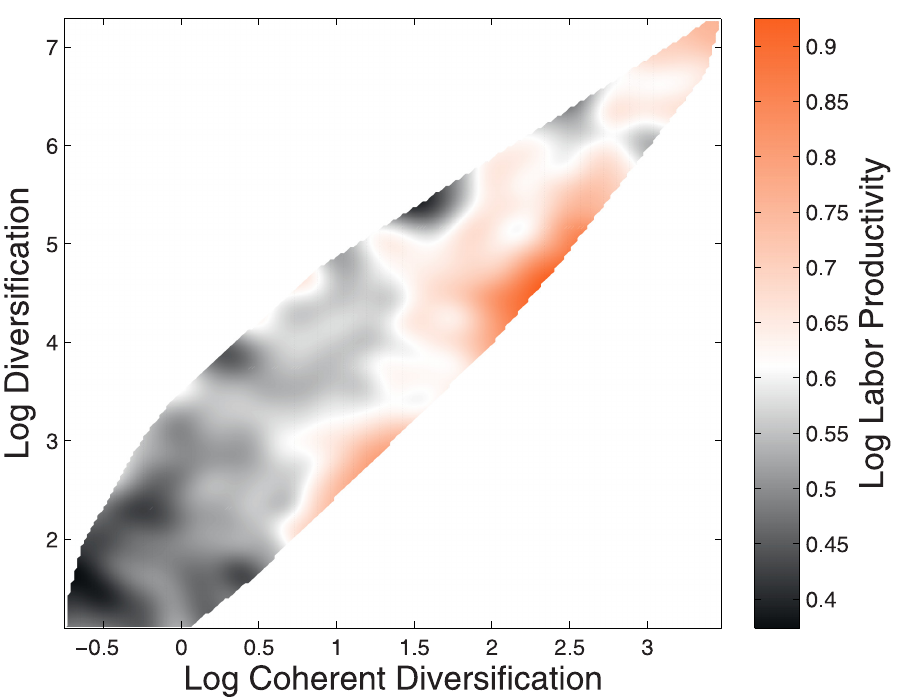
Fig 8. Labor productivity as a function of diversification and coherent diversification. Technological Diversification loses its explanatory power in favor of Coherent Technological Diversification when both are considered, in agreement with the regressions shown in Table 1. Notice that, given a fixed value of Technological Diversification, labor productivity tends to increase with Coherent Technological Diversification (i.e., from left to right, considering horizontal slices), while the opposite does not